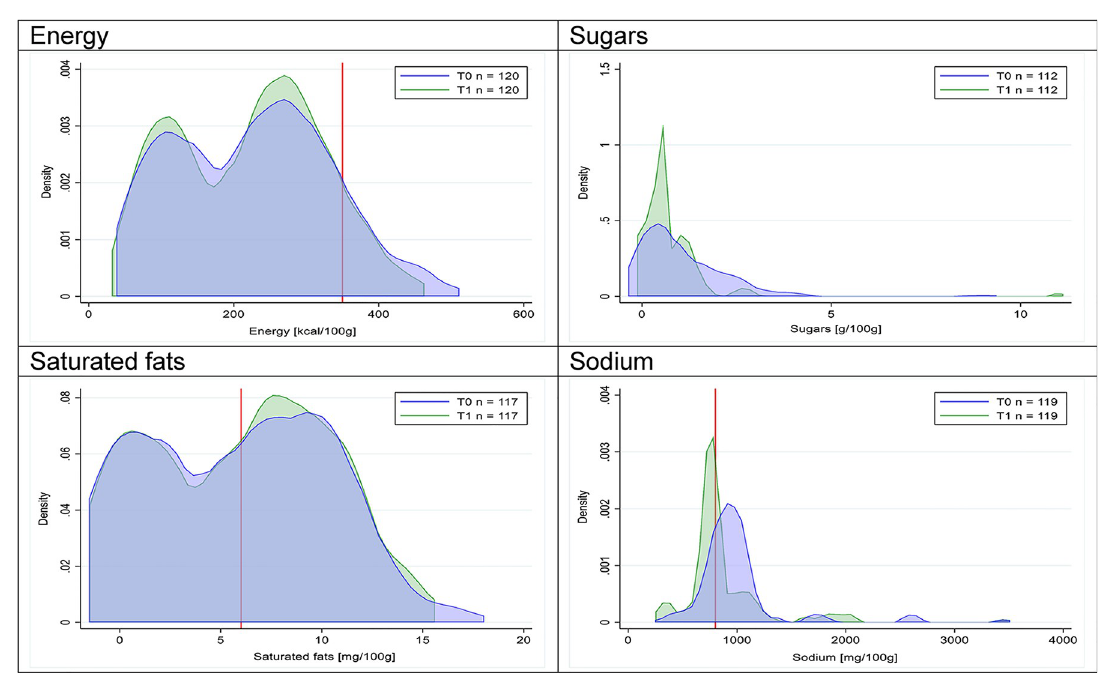
Fig 31. Density curves for the amount of energy and nutrients of concern in sausages, longitudinal subsample. The blue line represents the distribution in T0 (preimplementation), the green line represents the distribution in T1 (postimplementation), and the red line represents the cutoff for the amount of energy or nutrients of concern.